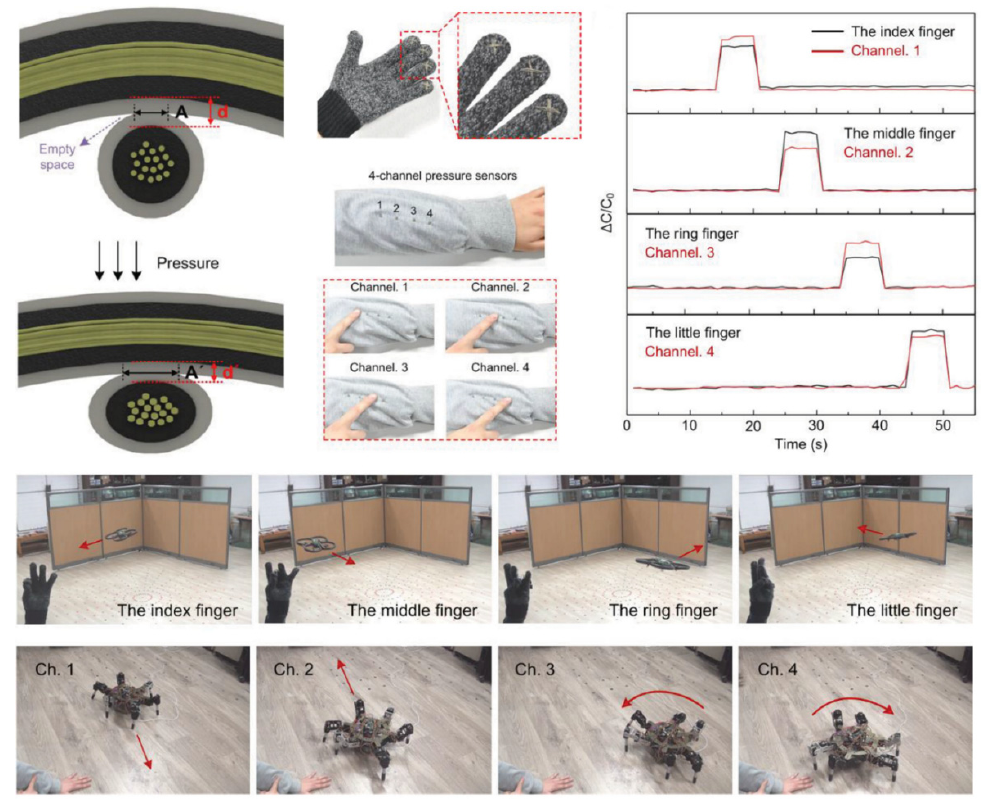
Figure 7. Remote control of a robot using pressure sensors for human-machine interfaces. Reproduced with permission from [141], Copyright (2015), Wiley-VCH.